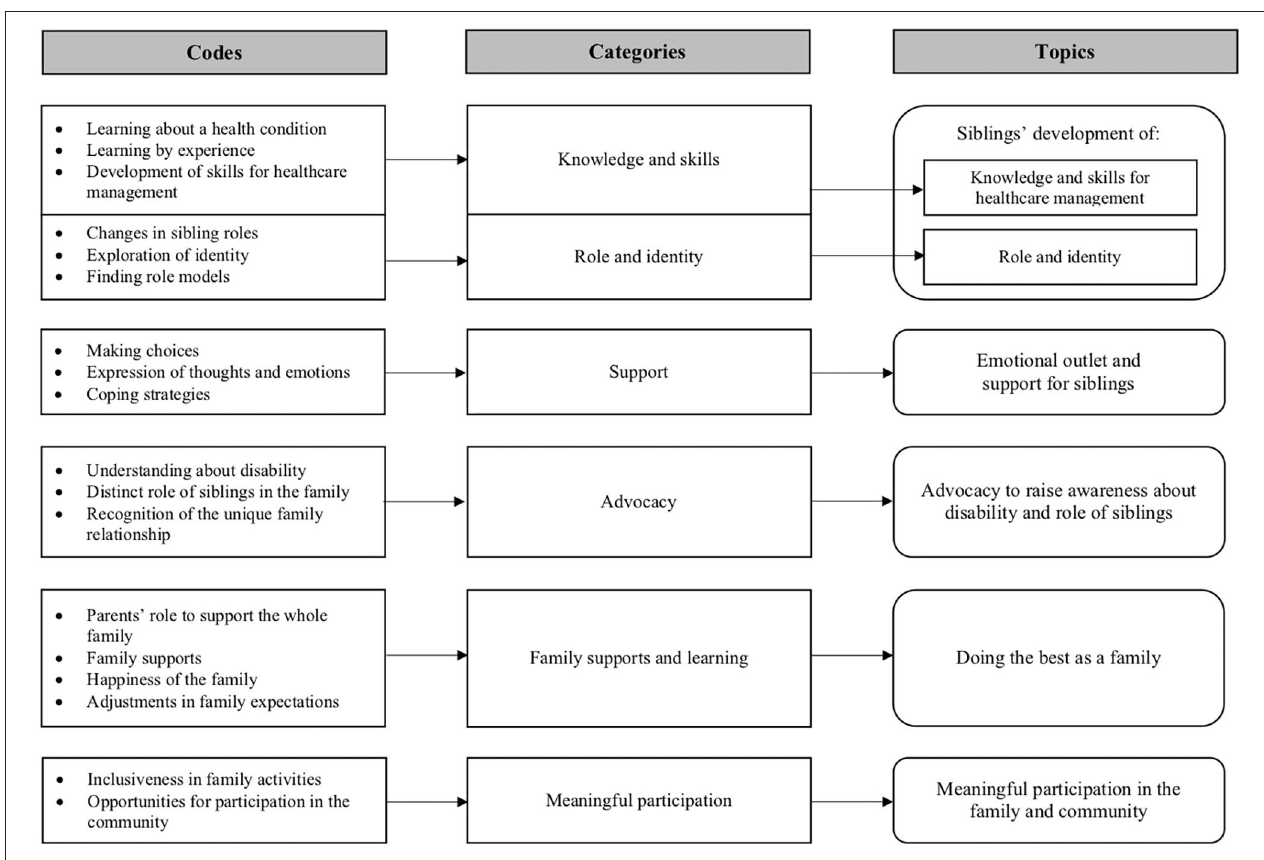
FIGURE 2 | Codes, categories, and topics indentified the blogs and interviews.